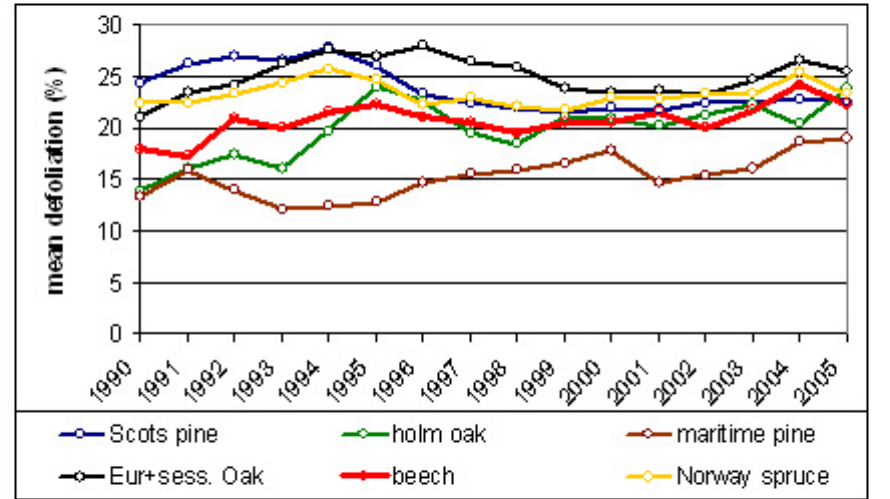
FIGURE 1. Development of mean defoliation of the six most common